Question: Reading the figure, is the described quantity rising or falling?
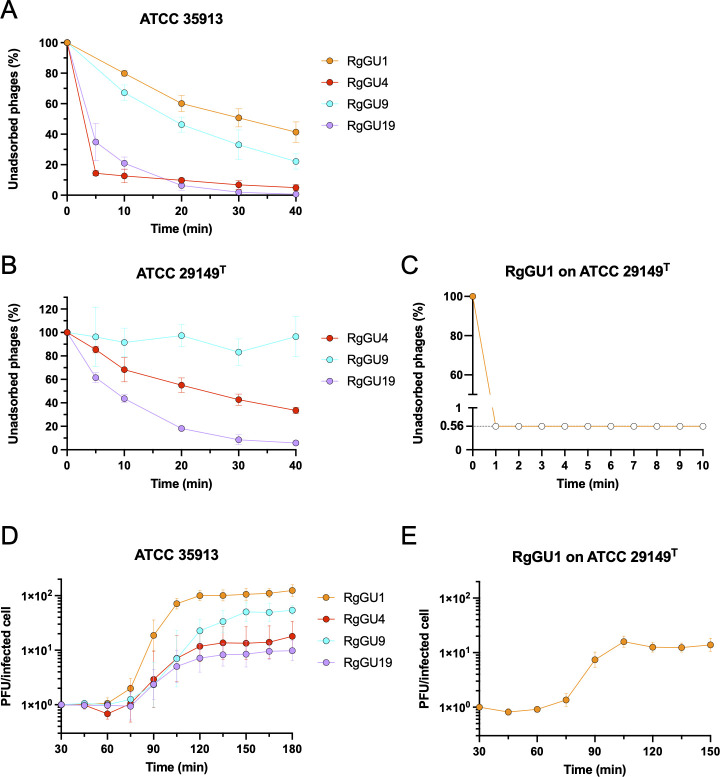
Answer: increasing